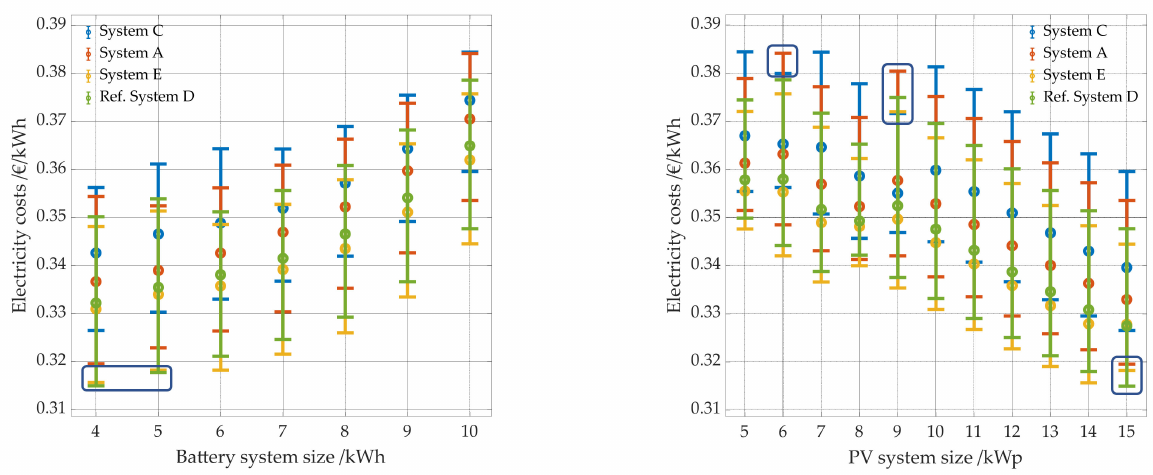
Figure 14. Electricity costs per kWh as a function of the battery system size ( left panel) and the PV system size ( right panel). Simulations were performed with the efficiency curves of systems C, A, E and D with an average pathway efficiency of 83.70, 89.35, 94.32 and 92.50% and for the AC2BAT path and of 83.70, 89.35, 94.32 and 92.50% for the path